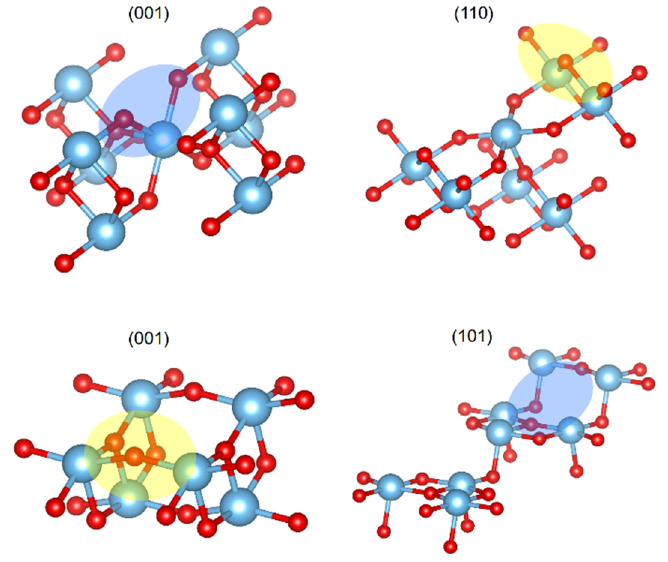
Figure 3. Representation of rutile ( top ) and anatase ( bottom ) studied planes. Regions top of the plane in yellow ovals and regions below of the plane in blue ovals. Titanium atoms are depicted as blue spheres and oxygen as red spheres.